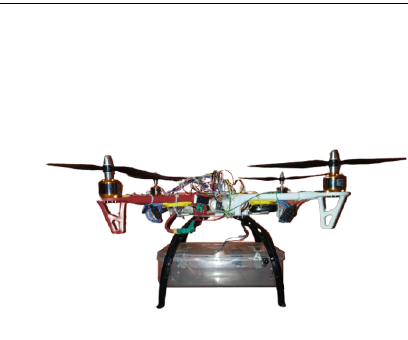
Figure 5. The implemented Drone with container attached (1)